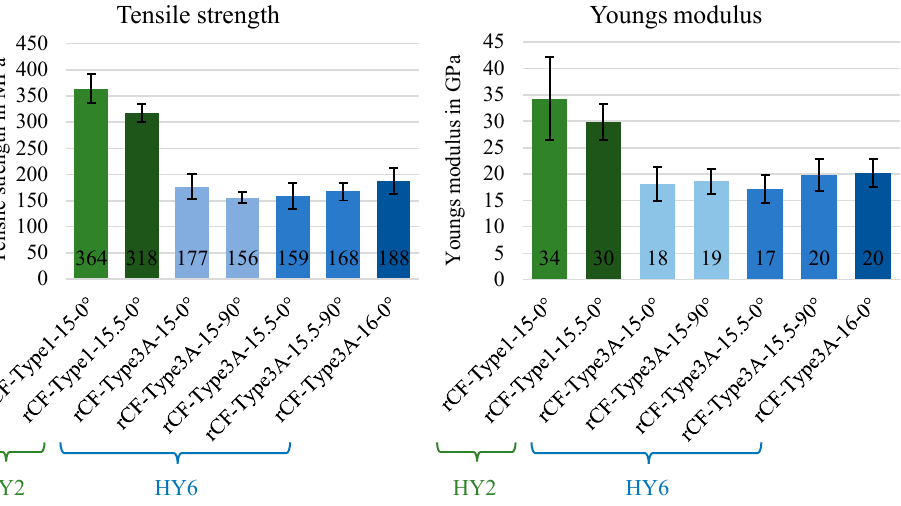
Figure 5. Measured fibre volume content by ashing using material made from HY6 (rCF-type 3), Indexation: rCF type 3 with sizing A (titanium oxide-based sizing)—stitch length in MLG (15/15.5/16 mm).